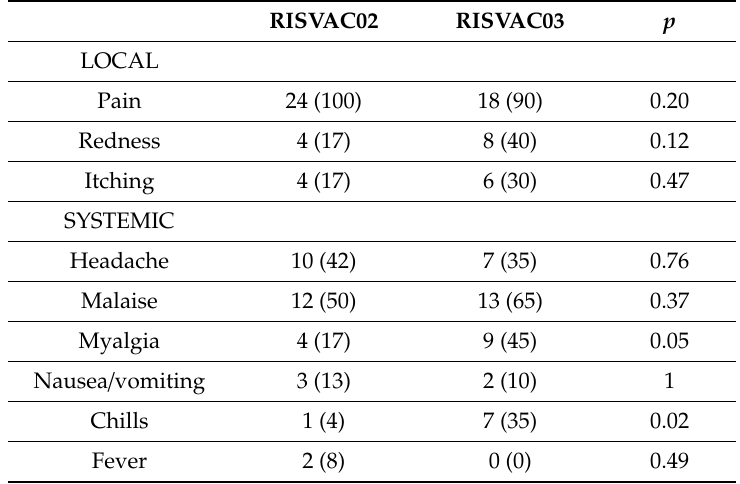
Table 2. Number of local and systemic adverse events in the RISVAC02 and RISVAC03 clinical